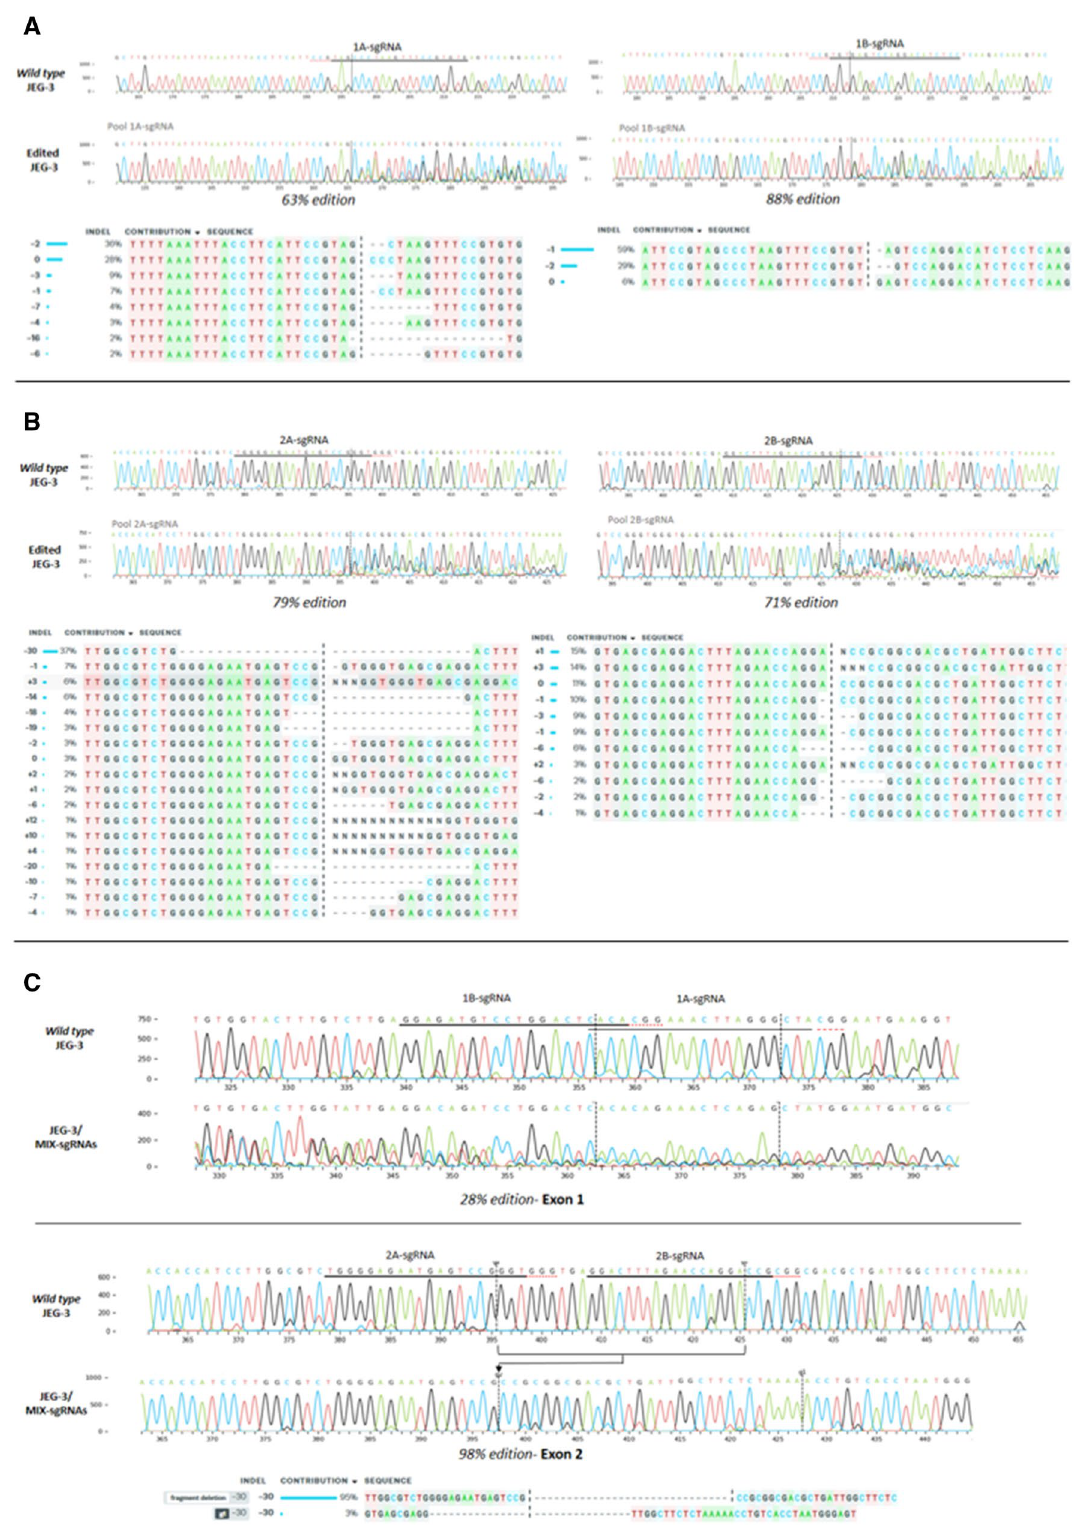
Figure 5. Sequencing analysis. Histograms with nucleotide sequence data of cell pools edited by CRISPR system. Different edited genotypes predicted by InDels analysis (https:// www. ice. synth ego. com/) and percentage of edition for each condition: ( A ) JEG-3 cell pools edited with 1A- and 1B-sgRNAs, in exon 1 region. ( B ) JEG-3 cell pools edited with 2A- and 2B-sgRNAs, in exon 2 region. ( C ) JEG-3 cell pools edited with all sgRNAs (1A, 1B, 2A and 2B, named JEG-3/MIX-sgRNAs), in exon 1 and 2